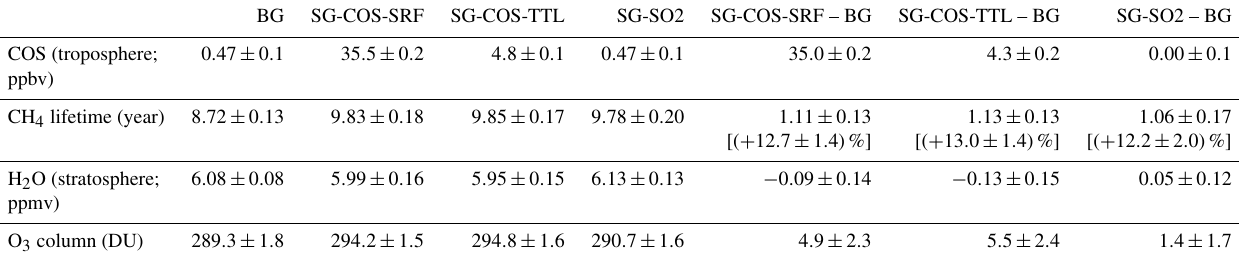
Table 4. Summary of calculated globally and annually averaged quantities of greenhouse gases directly and indirectly perturbed by SG and relevant for RF calculations (i.e. COS mean tropospheric mixing ratio, CH 4 atmospheric lifetime, H 2 O mean stratospheric mixing ratio, and O 3 column). The last two columns show the calculated SG changes with respect to the BG case (years 2046–2055). Note: ppmv is parts per million by